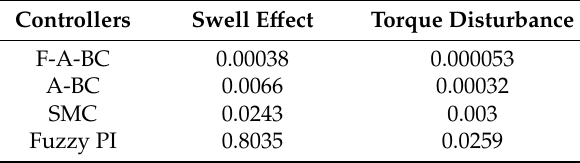
Figure 8. The rotor speed and rotor speed error responses under turbine torque disturbance. ( a ) The rotor speed response; ( b ) the error percentage of rotor speed. Table 3. The performance index of rotor speed under different controllers.